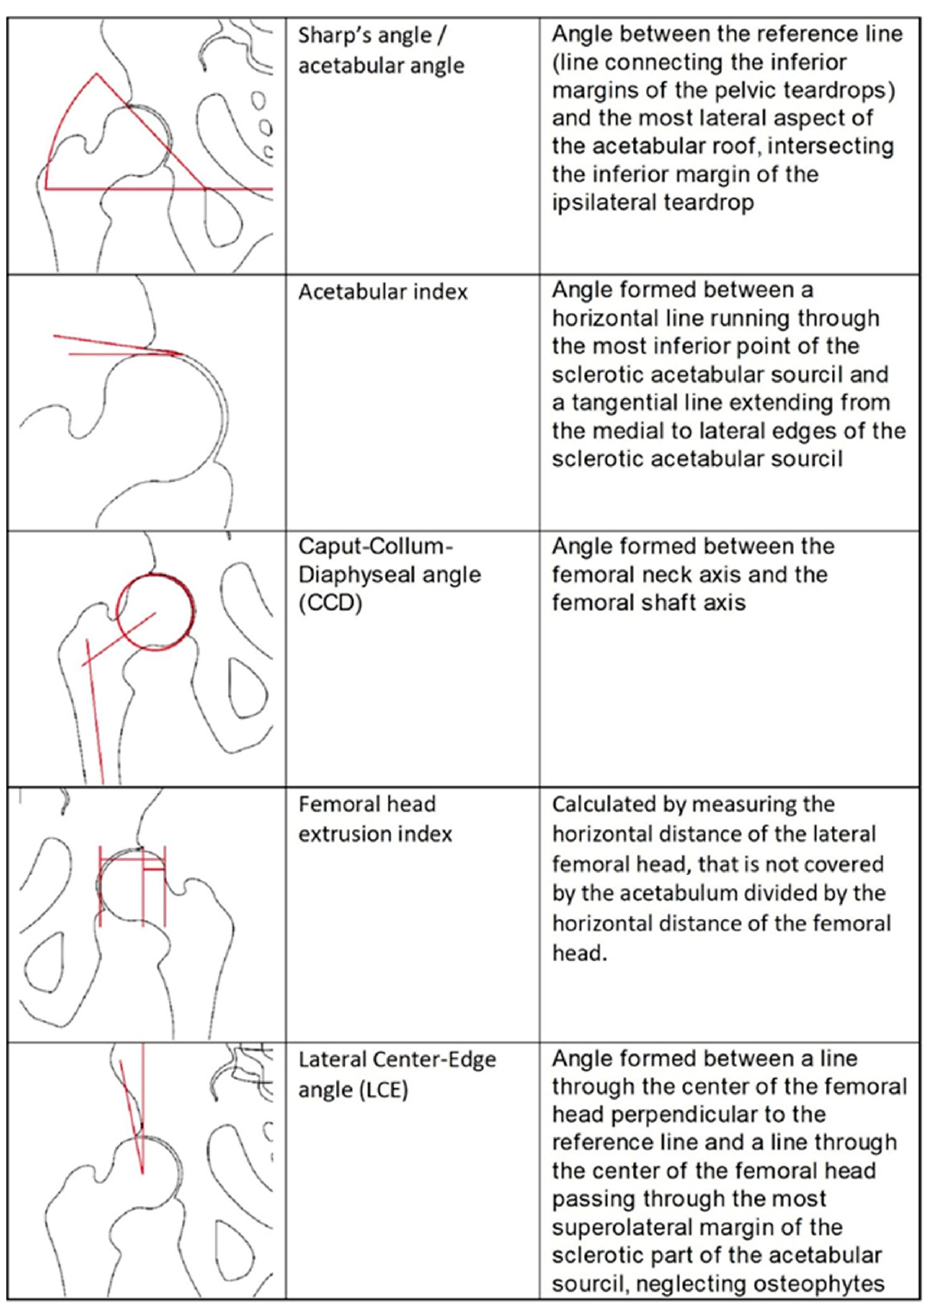
Figure 2. AI software (HIPPO™) report of an AP radiograph of the pelvis providing fully automated measurements.